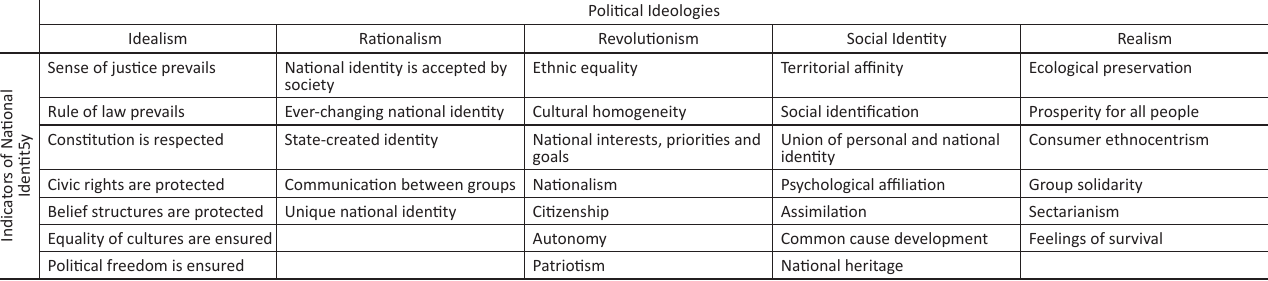
FIGURE 1: Ideological conceptualisation of national identity and its 32